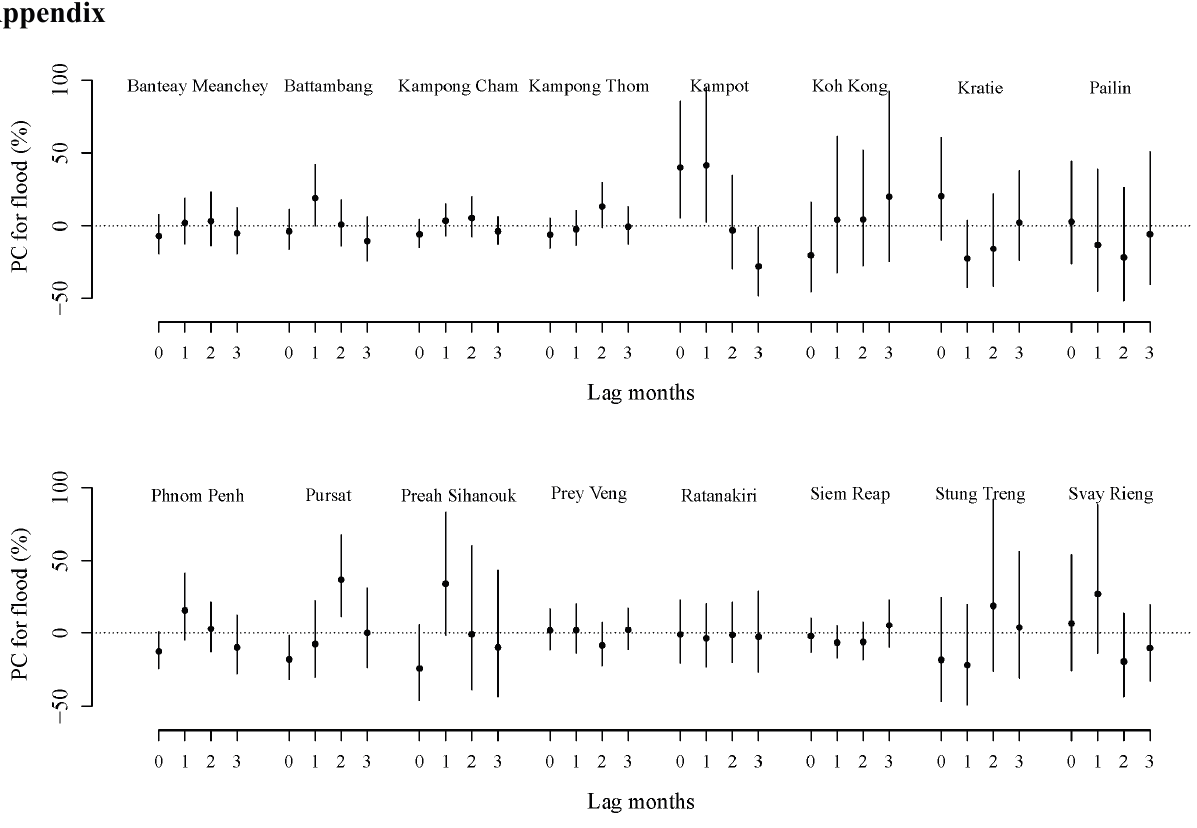
Figure A1. Flood effects on diarrhoea in 16 provinces adjusting for rainfall, temperature, long-term trend and